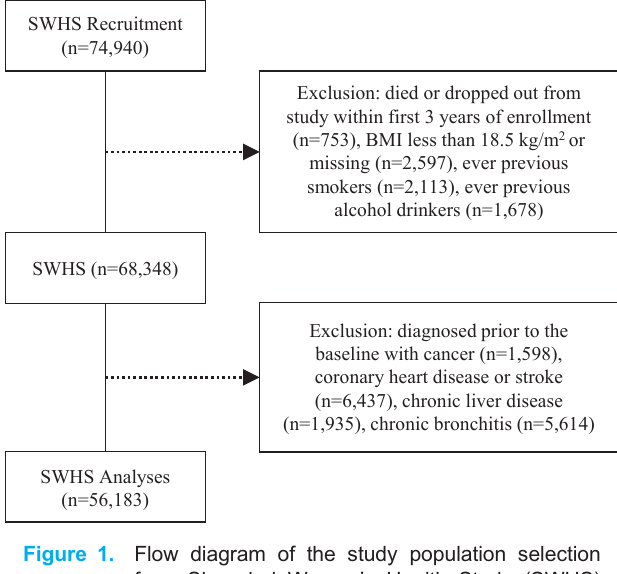
Figure 1. Flow diagram of the study population selection from Shanghai Women ’ s Health Study (SWHS) cohort. The results are not mutually